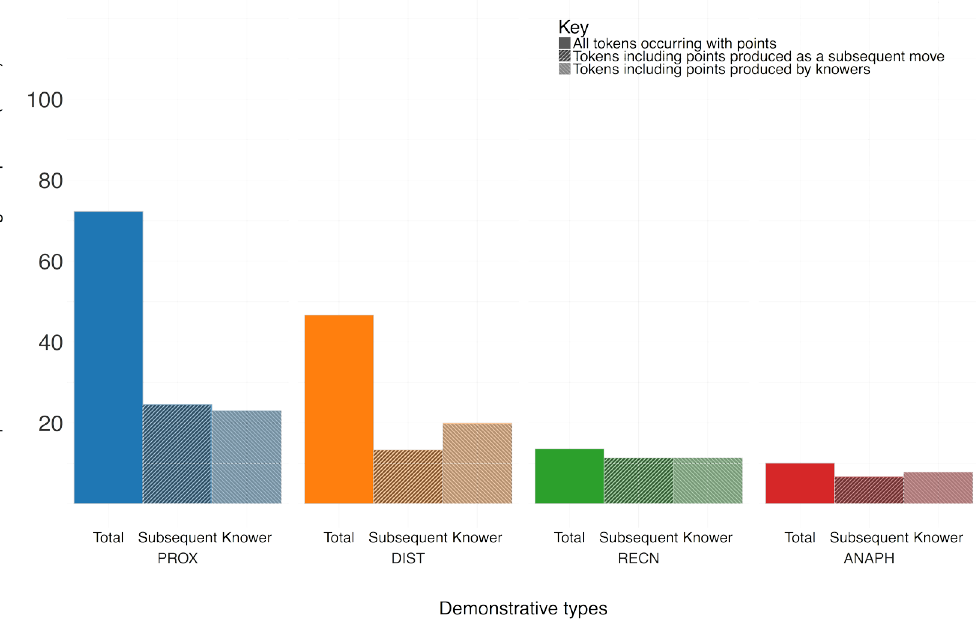
Figure 7: The solid bars on the left of each group show the proportions of the various demonstrative type tokens in the corpus that occur with points (Total). The darker hatched bars (in the middle) show the proportions of the various demonstrative type tokens occurring with points which are produced as subsequent moves (Subsequent). The lighter hatched bars on the right show the proportions of the various demonstrative type tokens occurring with points which are produced by the person that knows the intended destination